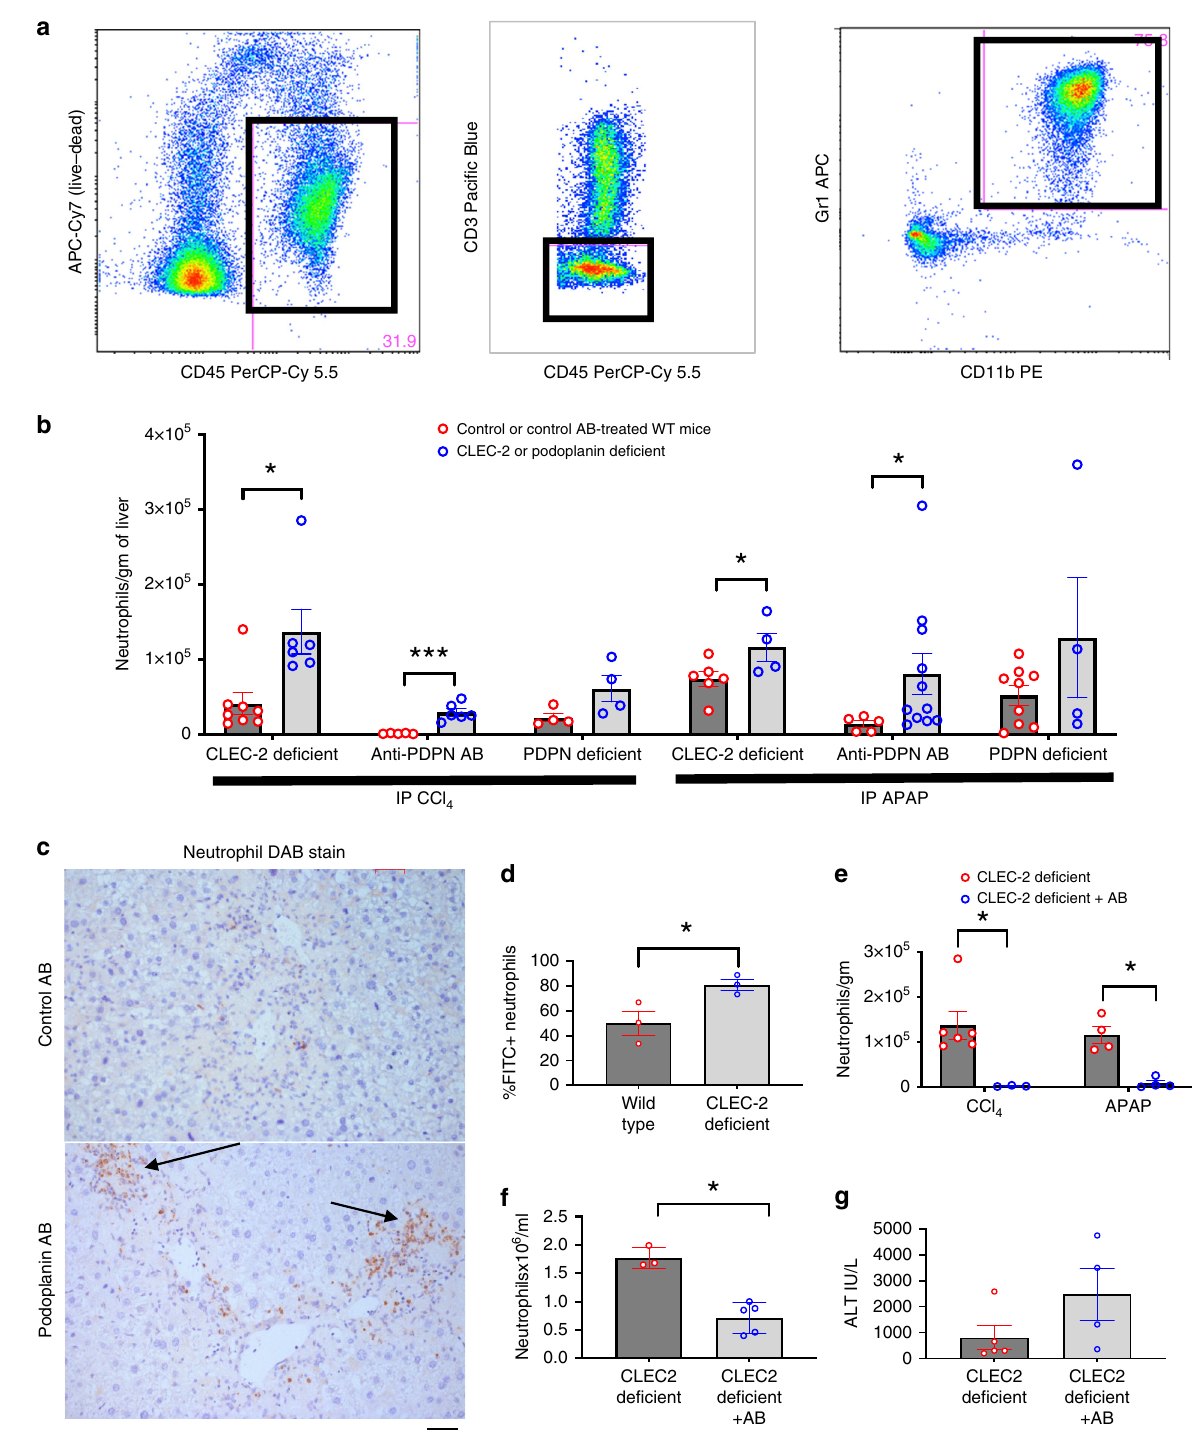
permeability, bacterial translocation 34 and the consumptive coa-